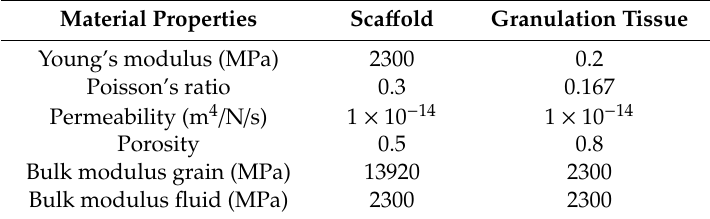
Table 1. Material properties utilized in the model of sca ff old and granulation